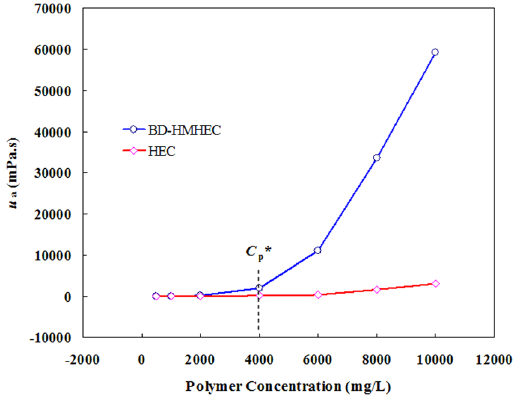
Figure 3. Effect of polymer concentration on u a of BD-HMHEC and HEC